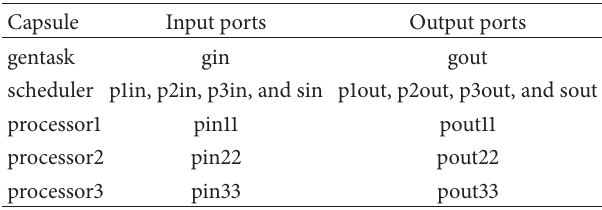
Table 1: Ports and capsules used in modelling multiprocessor architecture.